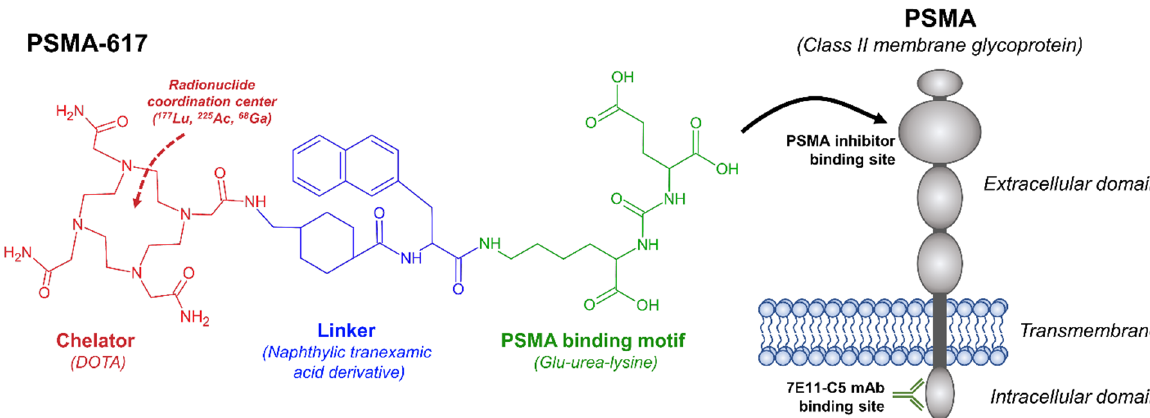
Figure 1. Structure of PSMA-617 with main components (chelator, linker, bonding motif) highlighted. PSMA-617, as well as other small-molecule PSMA inhibitors (DCFPyL, PSMA-11, PSMA-I&T), are targeted to the extracellular domain of PSMA, whereas 111 In-7E11-C5 (ProstaScint ® ) is now known to bind to the intracellular domain.